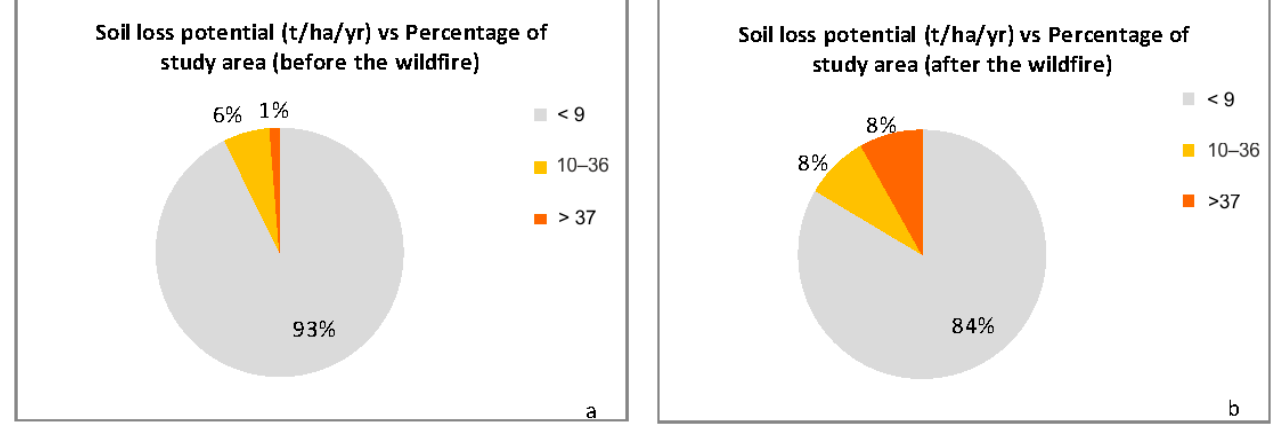
Figure 7. Soil loss potential for the total study area ( a ) before the wildfire and ( b ) after the